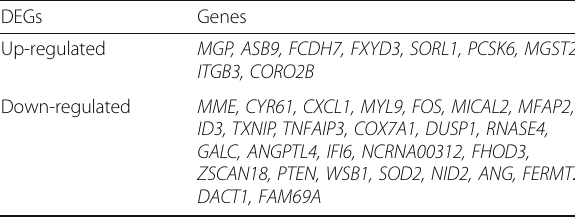
Table 1 Thirty-six differentially expressed genes (DEGs) were identified from melanoma, including 9 up-regulated genes and 27 down-regulated genes. (The up-regulated genes were listed from the largest to the smallest of fold changes, and down- regulated genes were listed from the smallest to